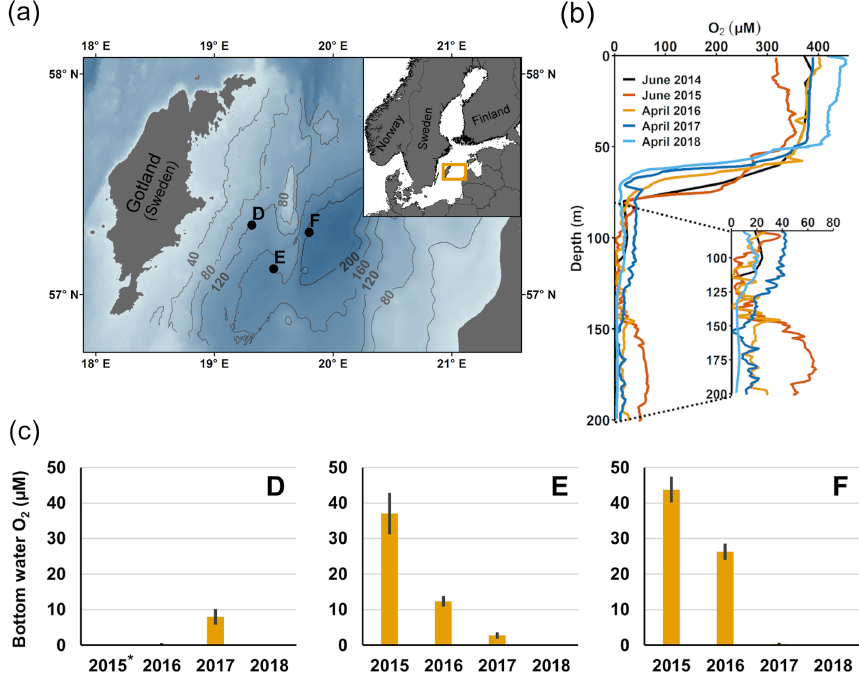
Figure 1. Description of sampling sites and oxygen conditions. (a) Map of the sampling sites in the Eastern Gotland Basin, Baltic Sea. Bathymetric data from the Baltic Sea Bathymetry Database (v. 0.9.3), the map was created using the software ArcMap™ (v. 10.6) by Esri. (b) Water column profiles of oxygen (O 2 ). Data from SMHI (SMHI, 2021; 2014, station BY15), Hall et al. (2017; 2015, station F) and van de Velde et al. (2020b; 2016–2018, station F). (c) Bottom water oxygen (O 2 ) concentrations at stations D–F measured by optodes on the benthic chamber lander (average ± standard deviation) ∼ 0.2m above the sediment. The detection limit was 0.5µM. Data from Hall et al. (2017) and van de Velde et al. (2020b). ∗ No